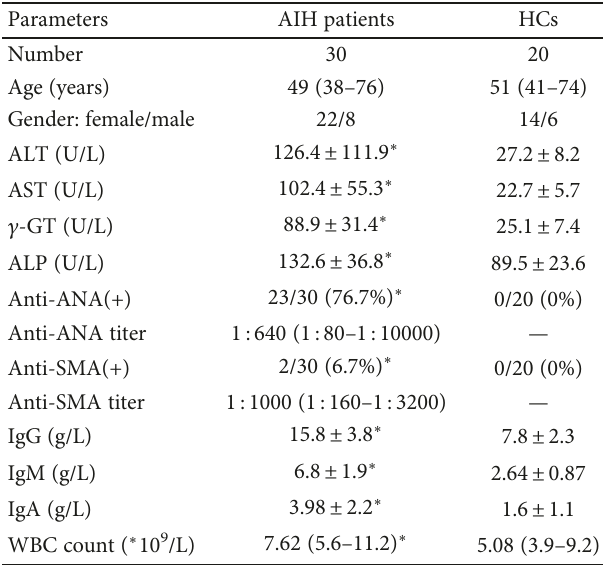
Table 1: Demographic and clinical characteristics of study